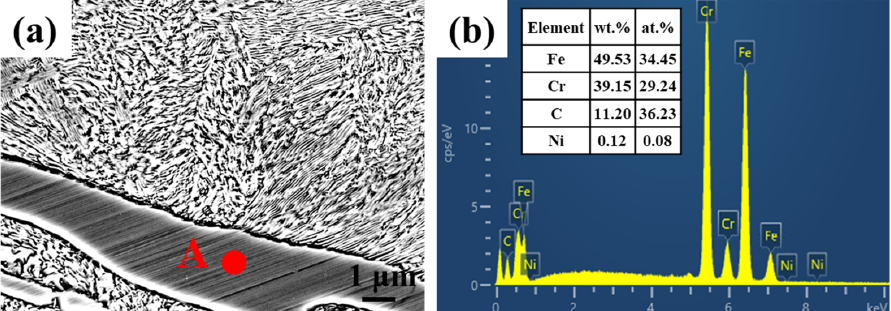
Figure 5. Enlarged SEM image and the EDS analysis of the eutectic carbide for CIC ‐ 3. ( a ) SEM image; ( b ) EDS analysis of point A. Table 2. Experimental and calculated volume fractions of M 7 C 3 .